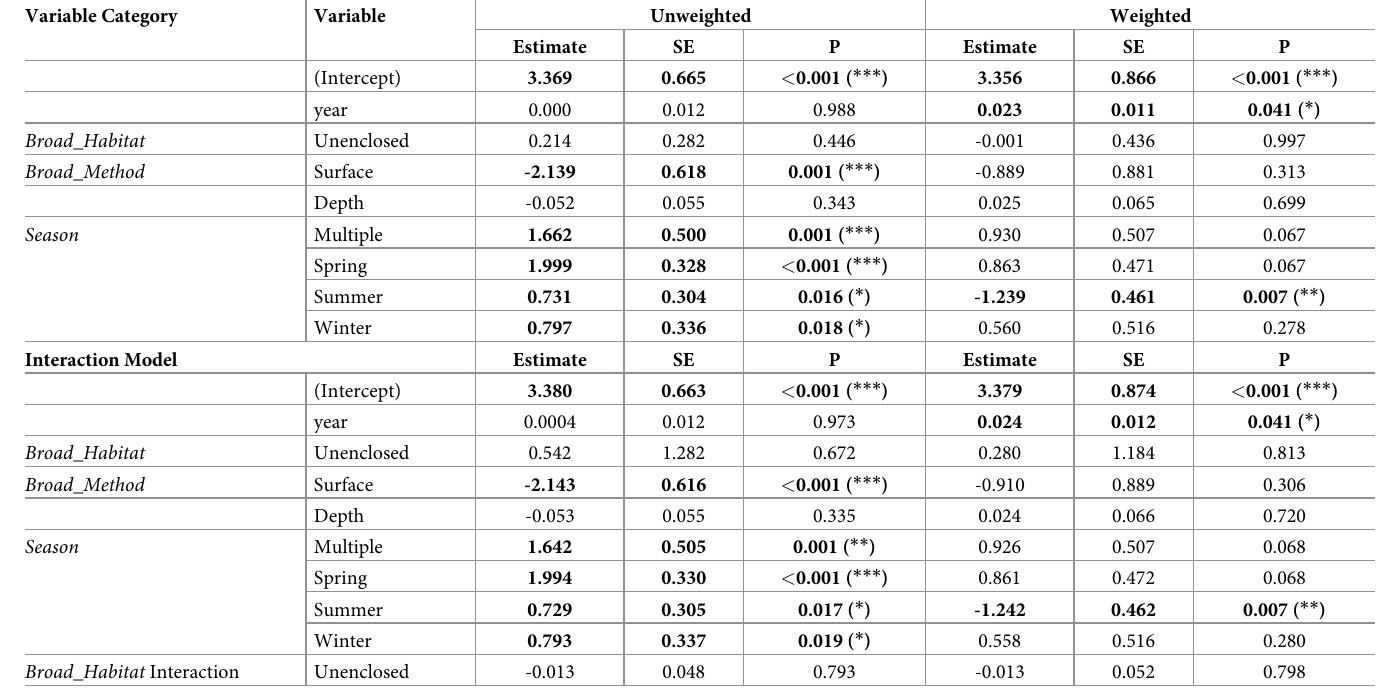
Table 7. Model 1 and 3 output of tipulid abundance and trends. Estimates from the tipulid models weighted (by the natural log of Sample Extent +1) and unweighted. Top is Model 1 and bottom is Model 3 with an interaction between Year and Broad_Habitat, compared to the base of Farmland, Core and Autumn. Significant estimates are in bold, the stars represent: * < 0.01, ** < 0.001, *** < 0.0001, SE = Standard